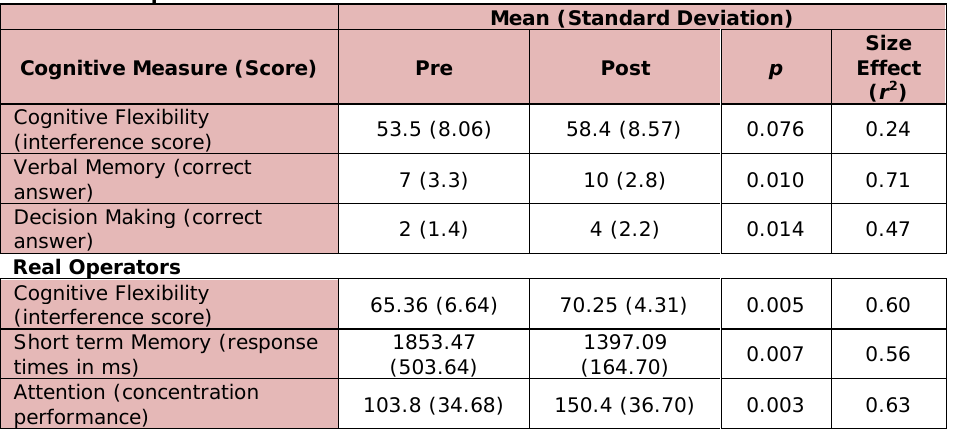
Table 3. “Summary of cognitive performance assessment in simulated and real operators”.Source: Own